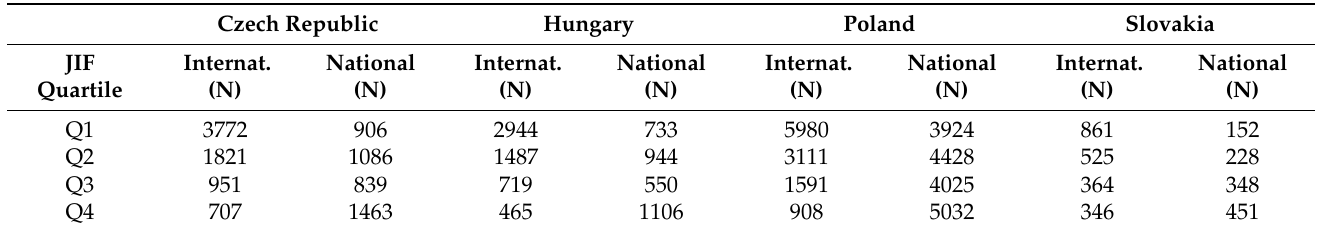
Table 1. The total number of research papers in international and national collaboration as a func- tion of the JIF quartile. The distribution of Q1 – Q4 research papers for each V4 country in interna- tional and national collaboration was observed from the InCites database. N corresponds to the number of research articles; Internat. = international collaboration.